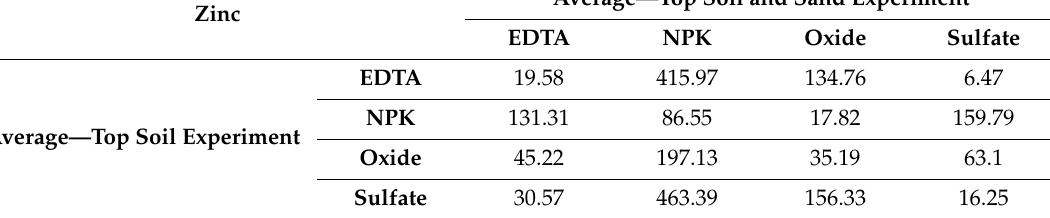
Table 4. Percentage di ff erences (%) in plant uptake of di ff erent sources of micronutrients between the two di ff erent media. These di ff erences show that plant nutrient uptake in the top soil media was more e ffi cient than in the top soil and sand